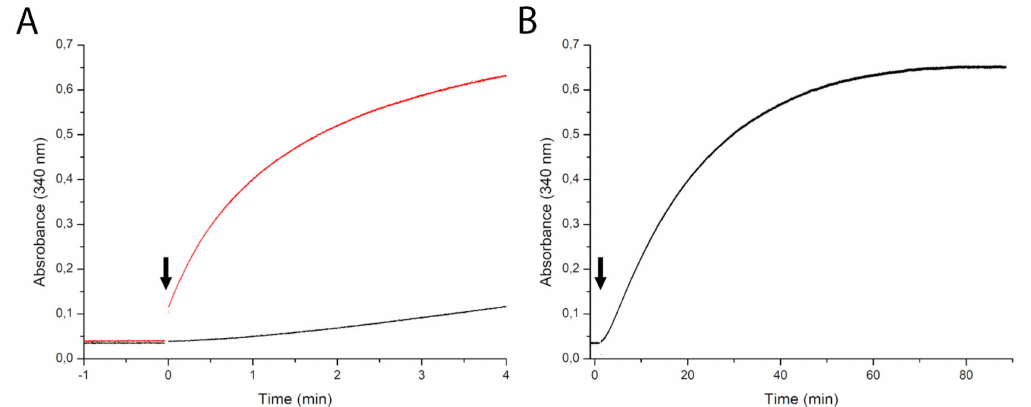
Figure 4. Time course of NADH formation with nicotinamide riboside as a substrate at two di ff erent protein concentrations (0.1 mg · mL − 1 (black line) and 1.0 mg · mL − 1 (red line), arrows indicate the addition of NadR) ( A ). Extended time scale (90 min) of the experiment with 0.1 mg · mL − 1 (black line) ( B